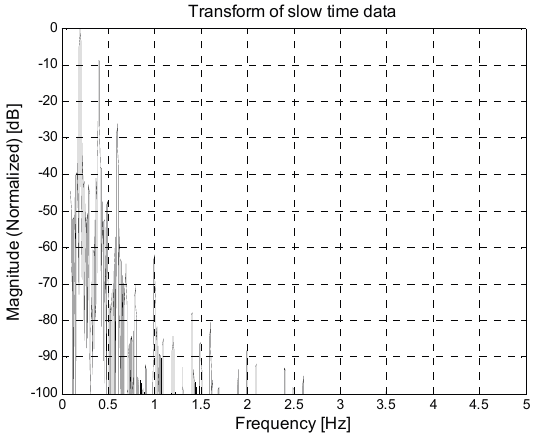
Figure 23. Spectral analysis in the absence of external EMI